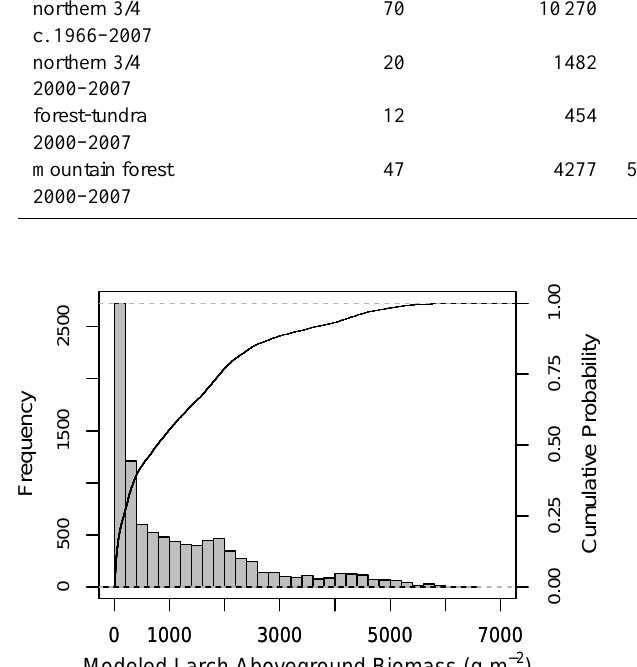
Fig. 5. Frequency and empirical cumulative distribution function plots of Cajander larch aboveground biomass modelled from Land- sat 5 satellite imagery (AGB LS ) in areas with no recent fire activity. Across the landscape, AGB LS ranged from 0.3 to 6703gm − 2 , with 50% of areas having less than 748gm − 2 .